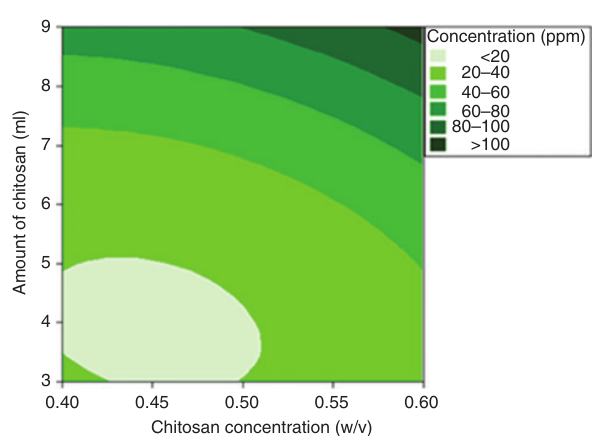
(nm) of the synthesized silver nano- Figure 4: Contour plot for λ max particles (AgNPs) solution as function of the amount and concentra- tion of chitosan solution.